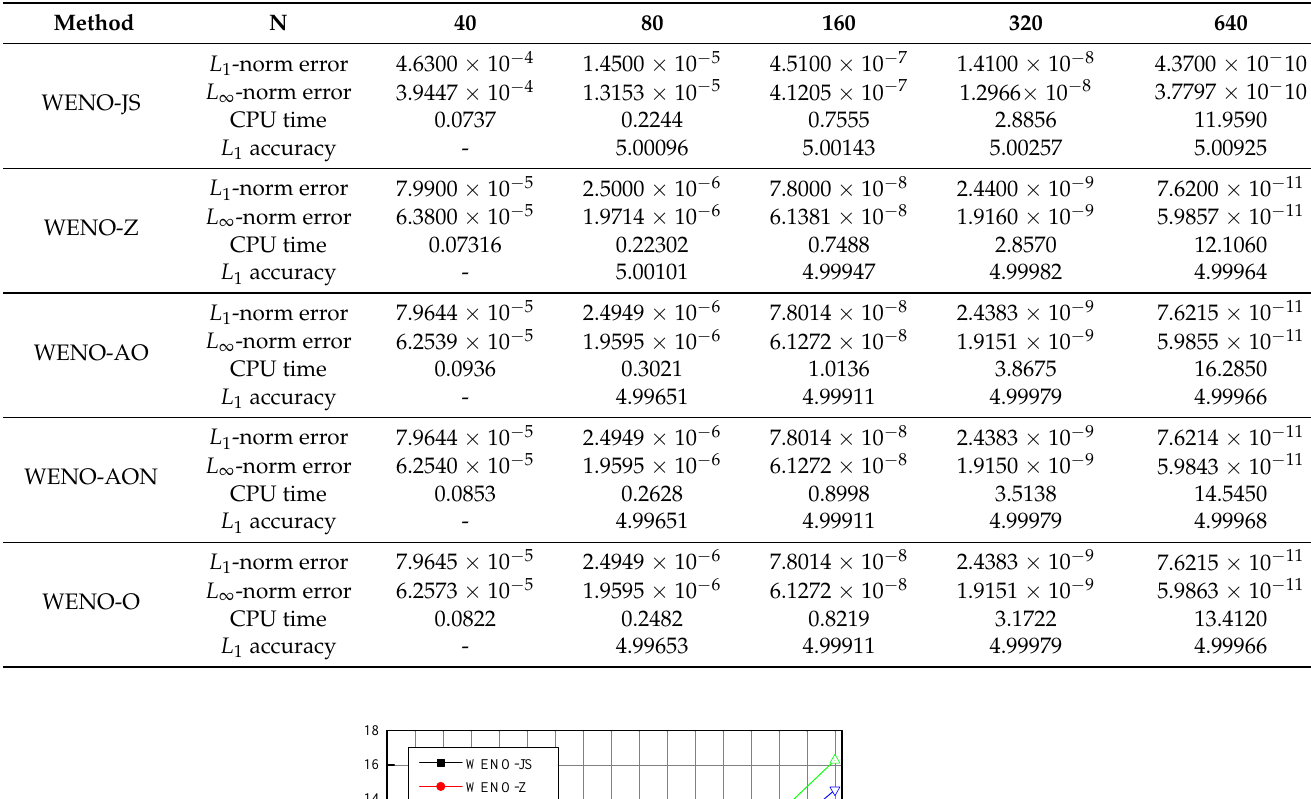
Table 3. The sine wave advection test accuracy (Section 6.1.1) with WENO-JS, WENO-AO, WENO-Z, WENO-AON and WENO-O schemes.